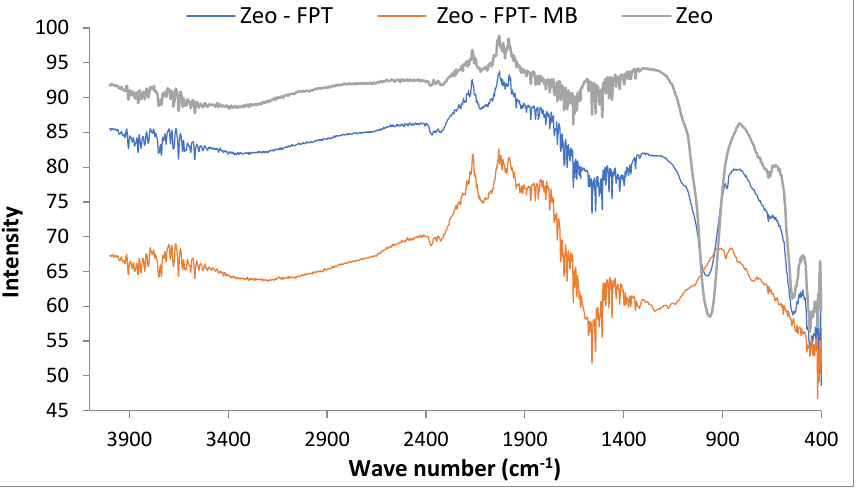
Figure 3. FTIR spectra of Zeo, the Zeo-FPT composite, and Zeo-FPT-MB dye after adsorption. Table 2. FTIR spectroscopy absorption bands of Zeo, FPT, and the Zeo-FPT